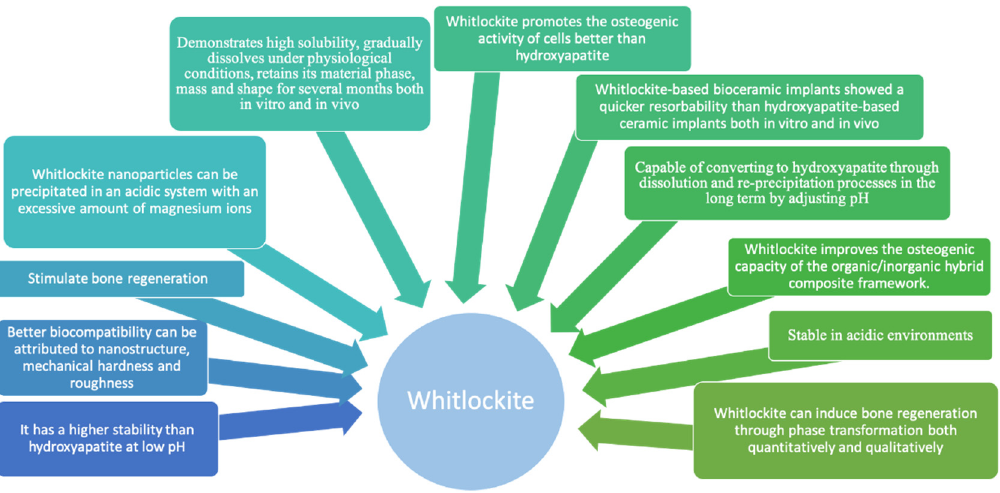
Figure 4. The role of whitlockite-containing biomaterials during